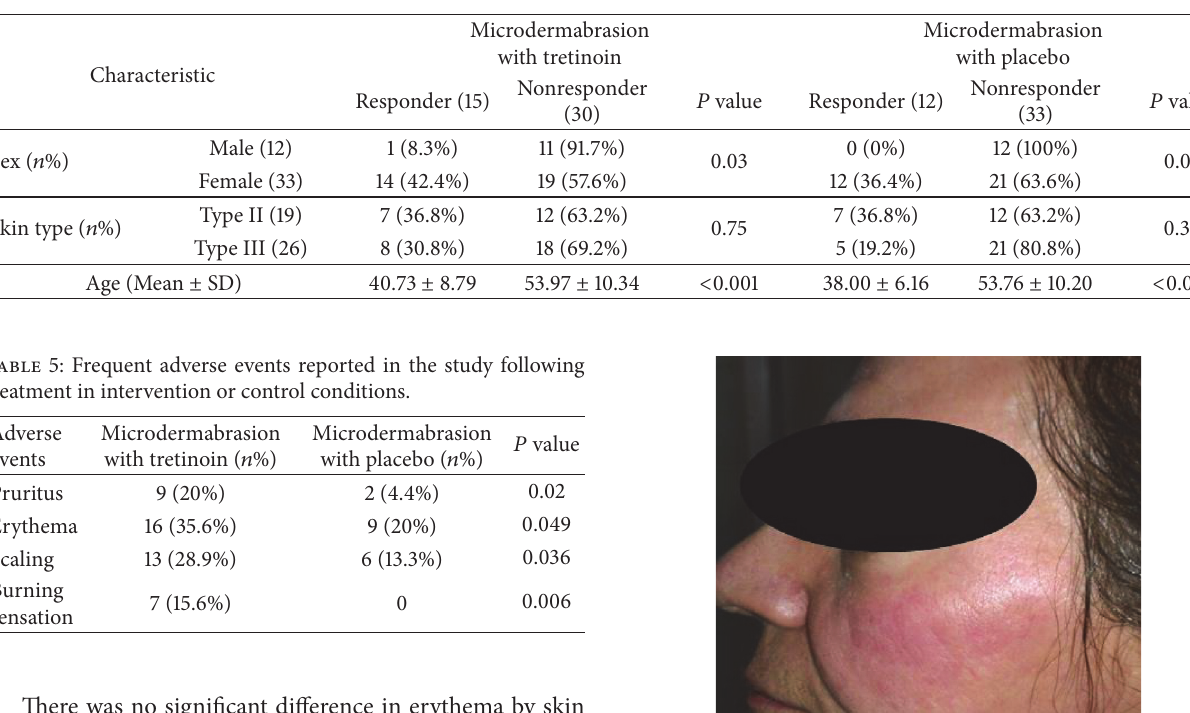
Table 4: Compression of responder and nonresponder participants in both groups by sex, skin phototype, and age.